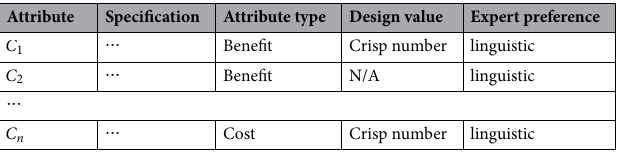
Table 3. Attributes defined in the real-life